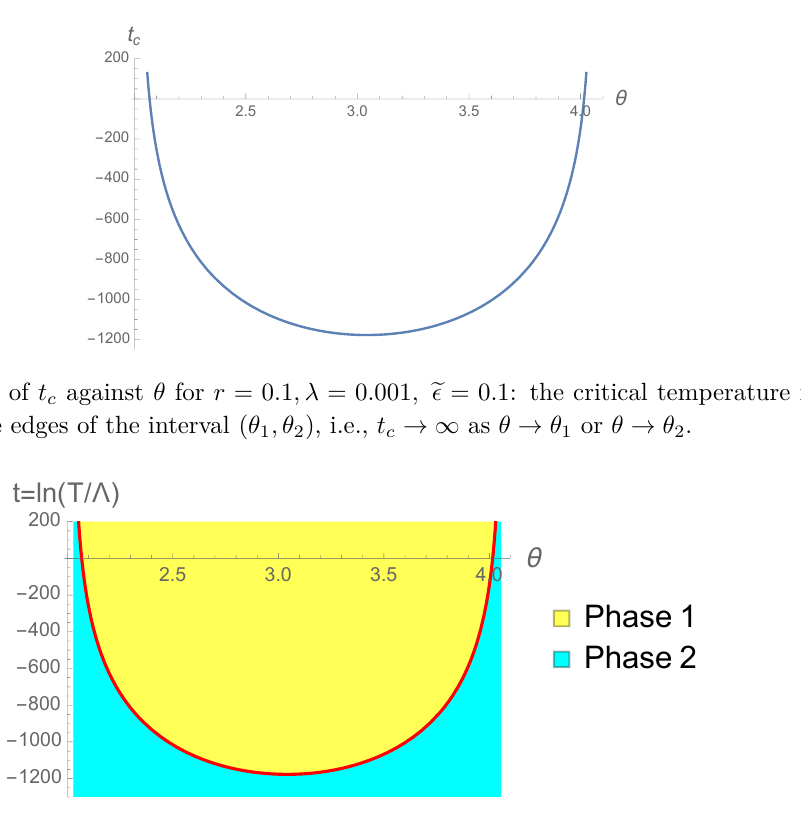
(cid:15) = 0 . 1 : in Phase 1, the e